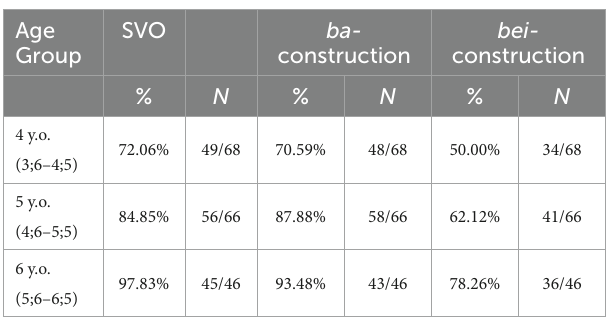
TABLE 3 Percentages (%) and counts ( N ) of errors in comprehension of SVO sentences. Age group